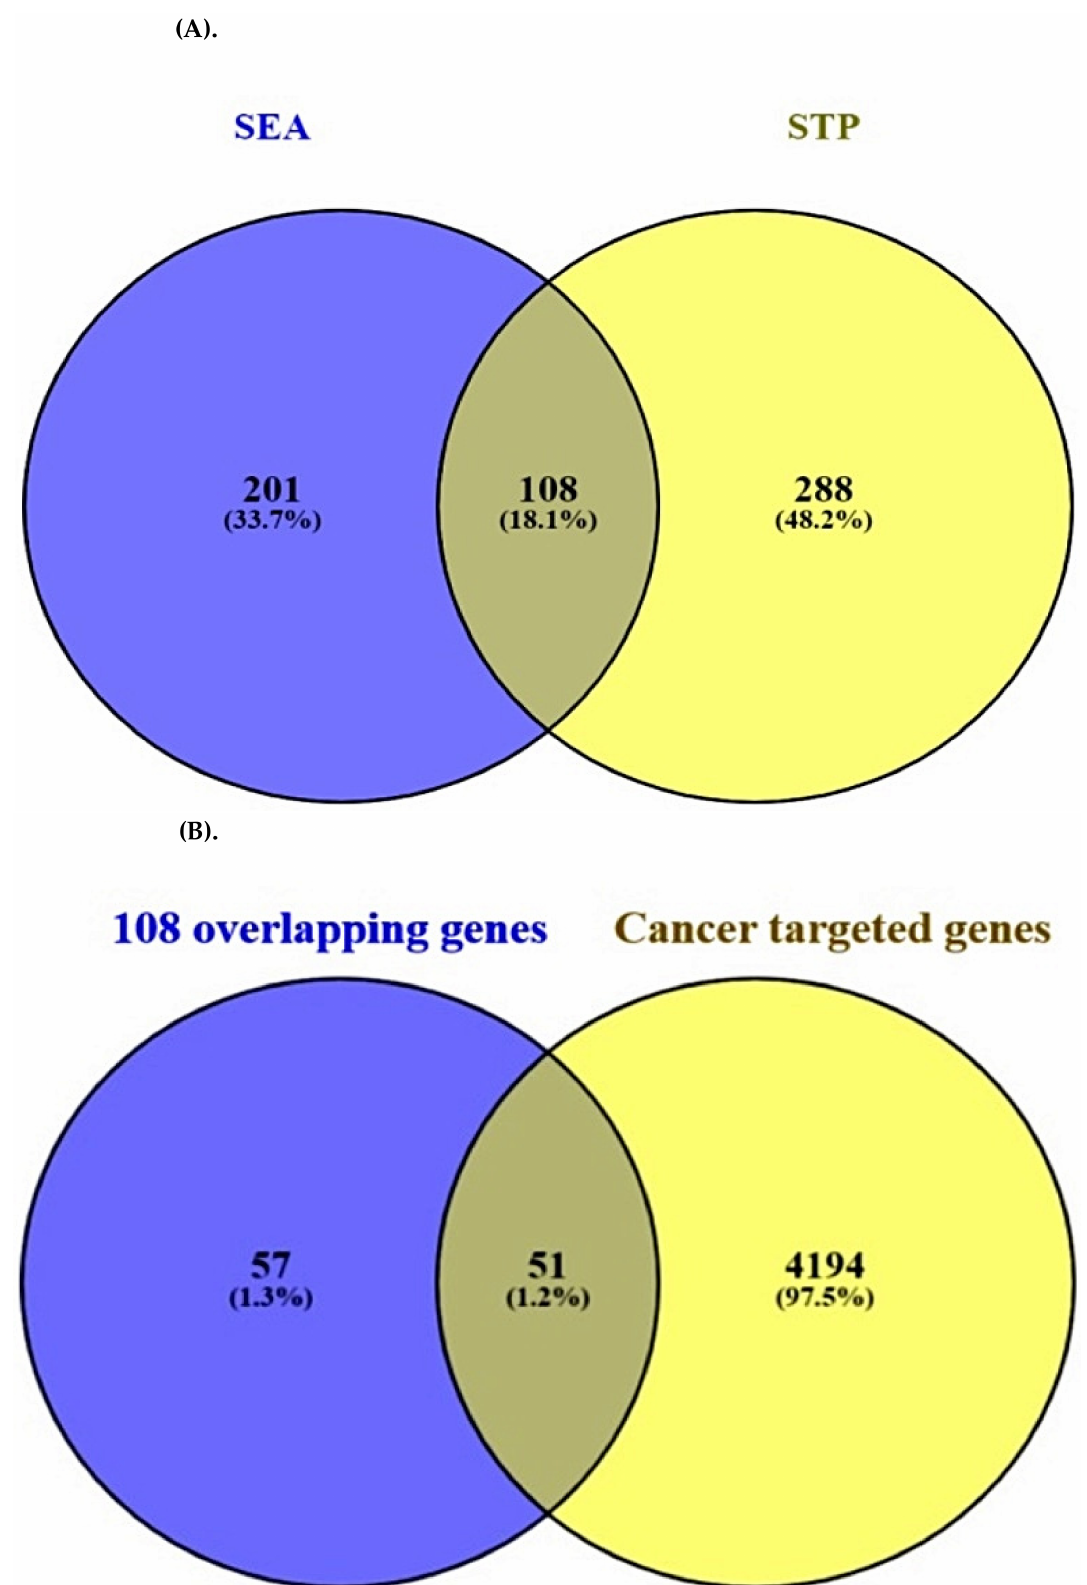
Figure 3. ( A ) Overlapping targets (108 targets) between SEA (309 targets) and STP (396 targets). ( B ) Overlapping targets (51 targets) between 108 overlapping targets from two databases (SEA and STP) and cancer associated with targets (4245